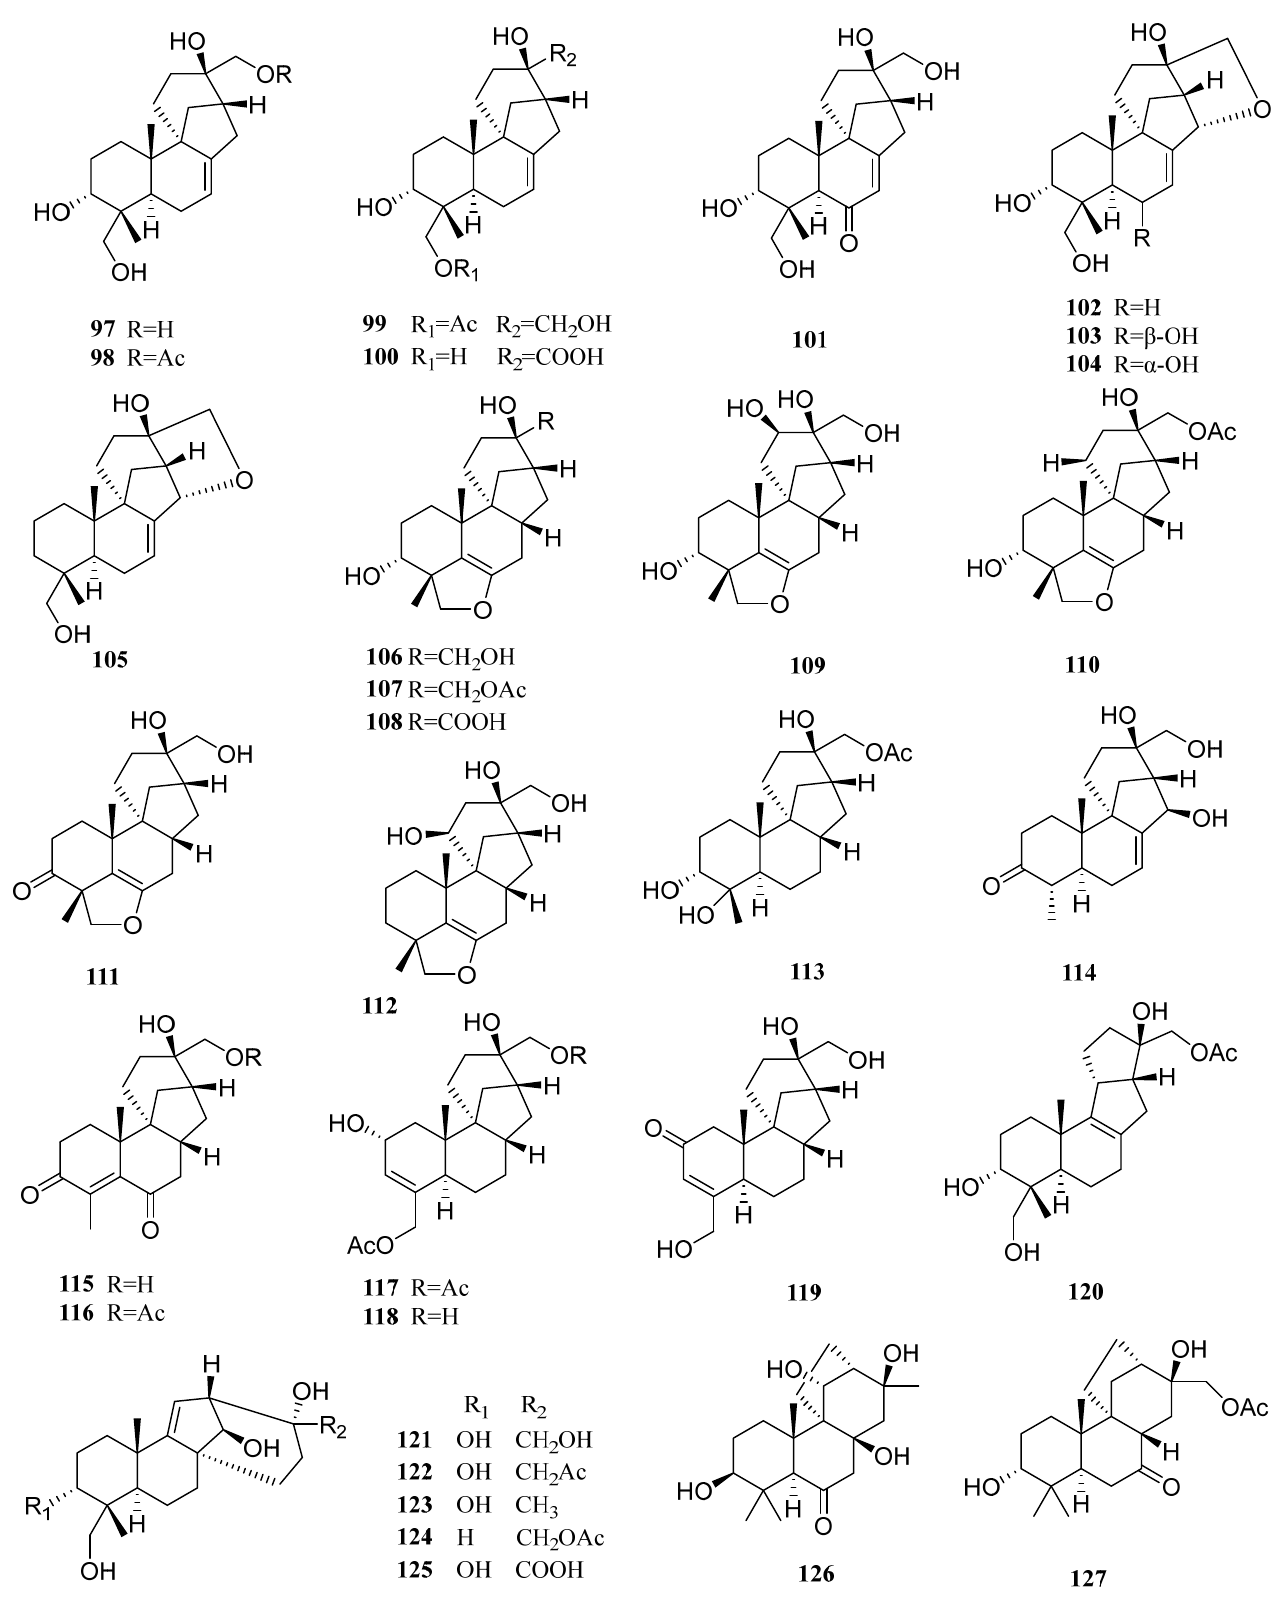
Figure 6. Chemical structures of diterpenes ( 48 – 127 from Botryotinia sp.).